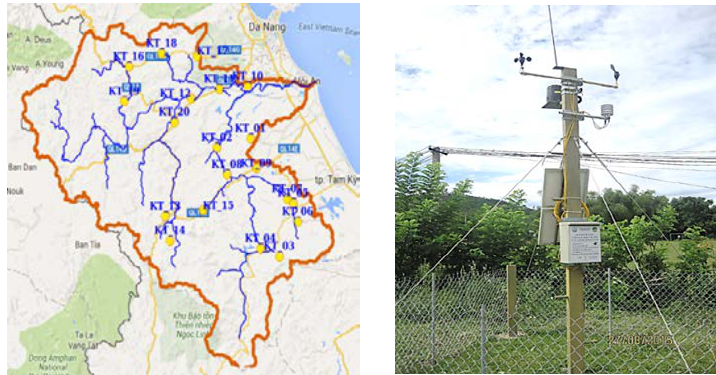
Figure 12. The validation water level at the Cau Lau hydrological station in the VGTB river basin during October 31–November 7, 2016 flood event.